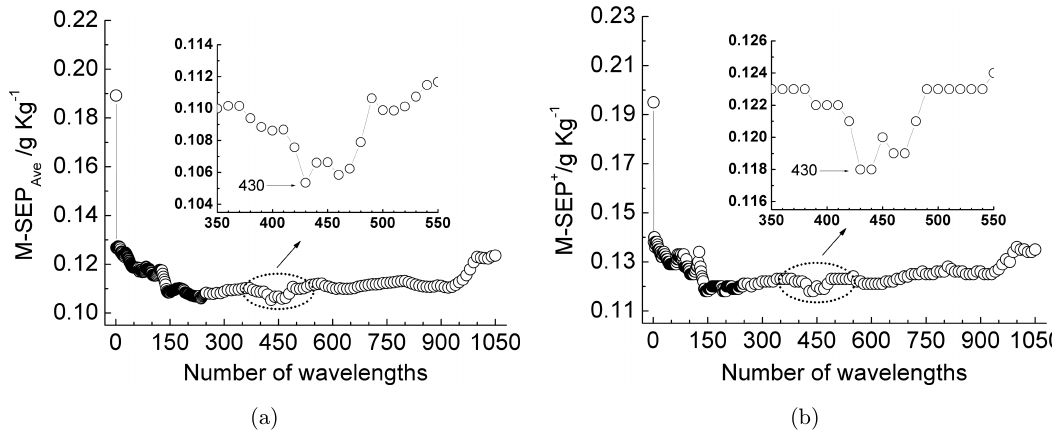
Fig. 4. M-SEP Ave and M-SEP þ of the local optimal model for each N : (a) M-SEP Ave and (b) M-SEP þ .